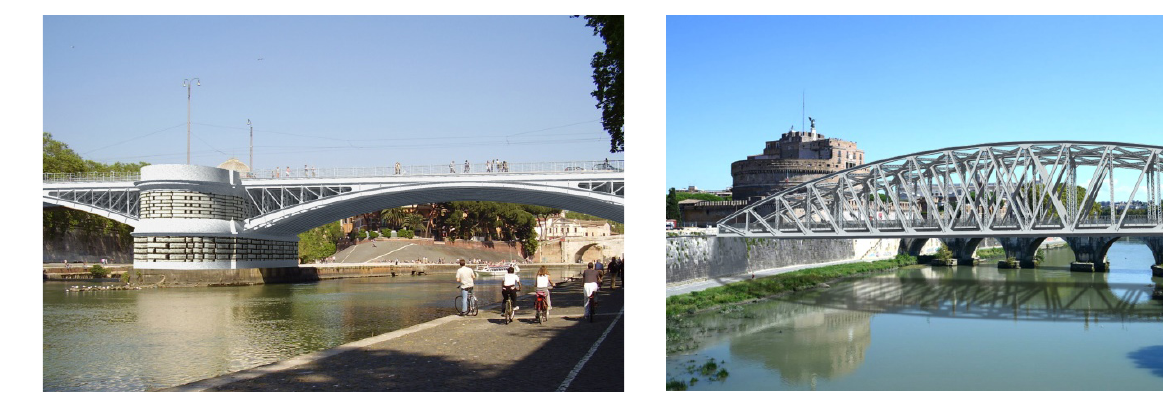
Figure 14. The virtual reconstruction of Garibaldi Bridge inserted in the area of Tiber Island